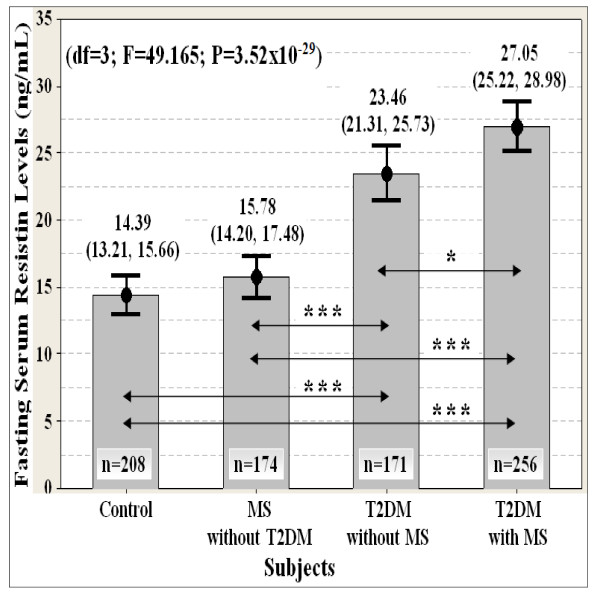
Association of fasting serum resistin levels with T2DM and MS susceptibility (n = 809). Data are expressed as mean (95% confident interval). ANCOVA test was used, followed by pairwise comparison using 1,000 stratified bootstrap samples with bias corrected and accelerated (BCa) 95% CI for multiple testing bias corrections due to deviation of normality. The p-value was also adjusted for covariate ages with stratified ethnicity. The location of statistically significant differences are displayed as the double arrow. Significant levels: P* < 0.05, P** < 0.01, P*** < 0.001. Note: T2DM = type 2 diabetes; MS = metabolic syndrome.